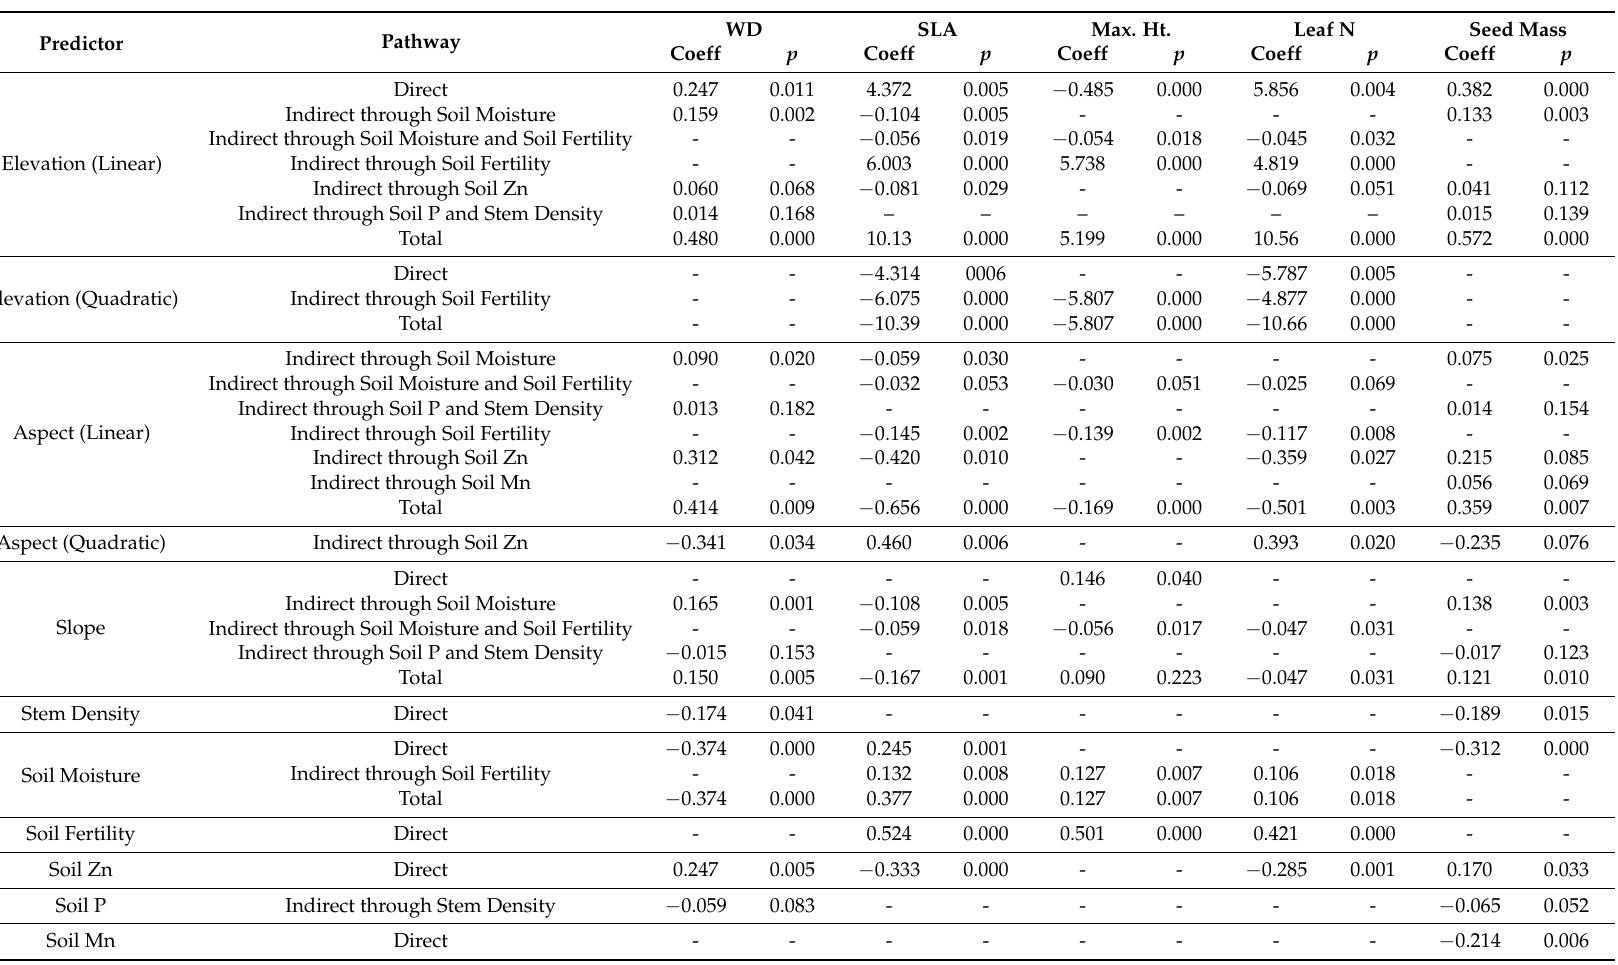
Table 3. Direct, indirect, and total path coefficients (standardized) of path models for community-weighted mean trait values (CWM). Traits were wood density (WD), specific leaf area (SLA), maximum height (Max. Ht.), leaf nitrogen content (Leaf N), and seed mass. Soil Fertility is a PCA axis representing soil pH, Base Cation Saturation, and available Ca, Mg, and